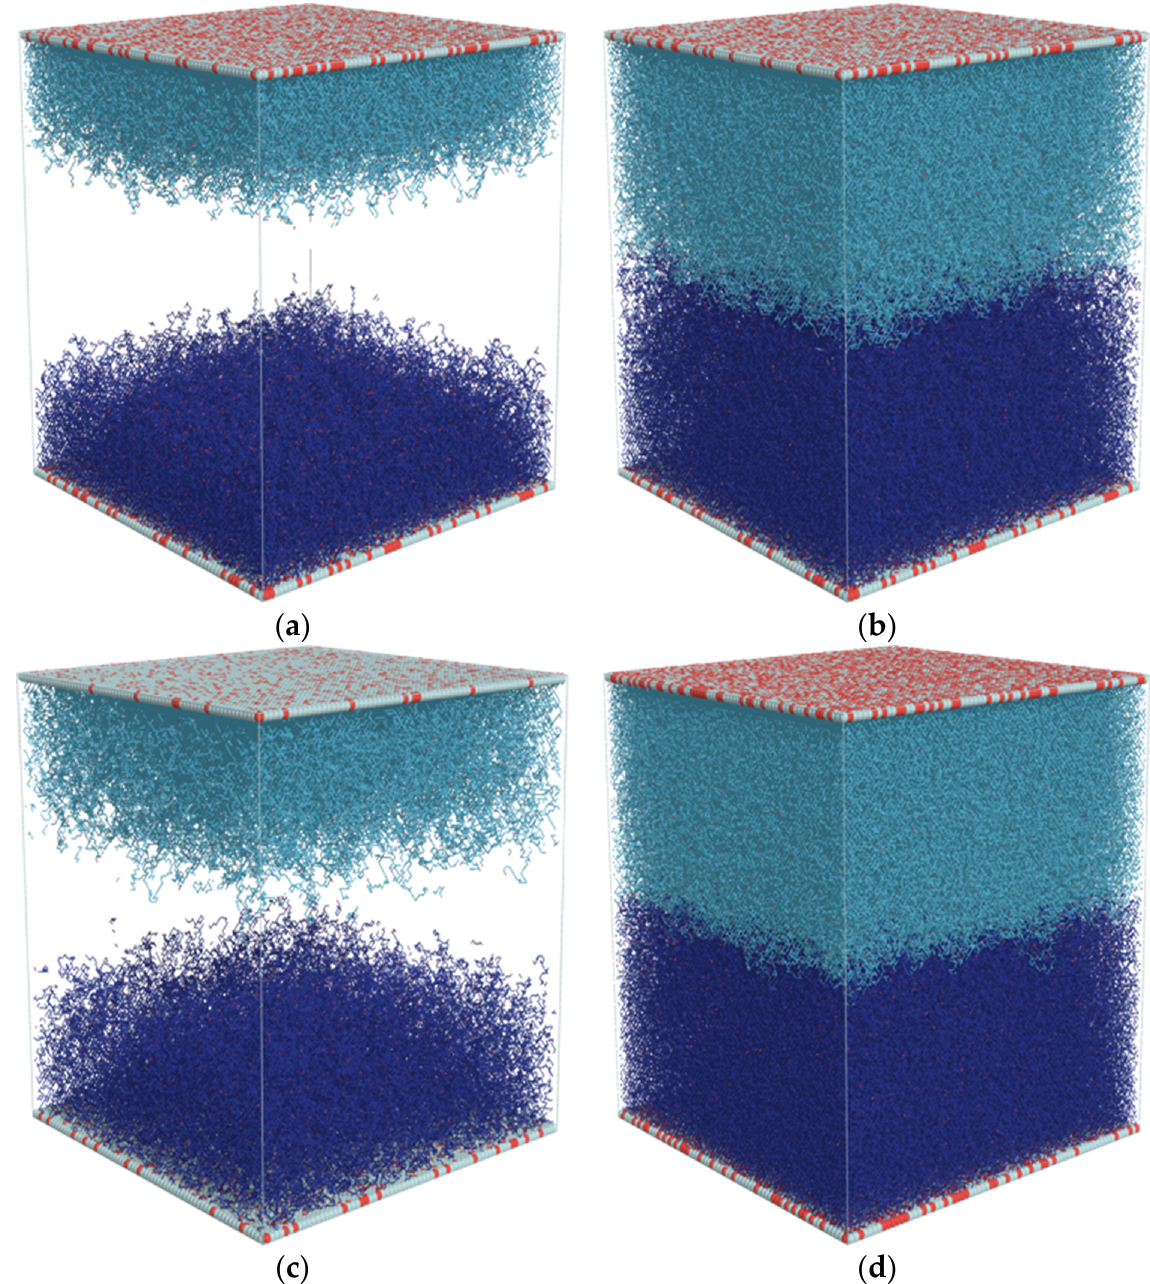
Figure 3. Configuration of an opposing polymer brush system for various values of DP n and grafting density σ . Each brush is displayed in a different color. Red dots mark ends of the polymer chains. σ = 0.1 grafting density was shown to present that in this case the brushes are not in contact. The cases of σ = 0.3, DP n = 50 ( a ); σ = 0.3, DP n = 110 ( b ); σ = 0.1, DP n = 110 ( c ); and σ = 0.4, DP n = 110 ( d ).